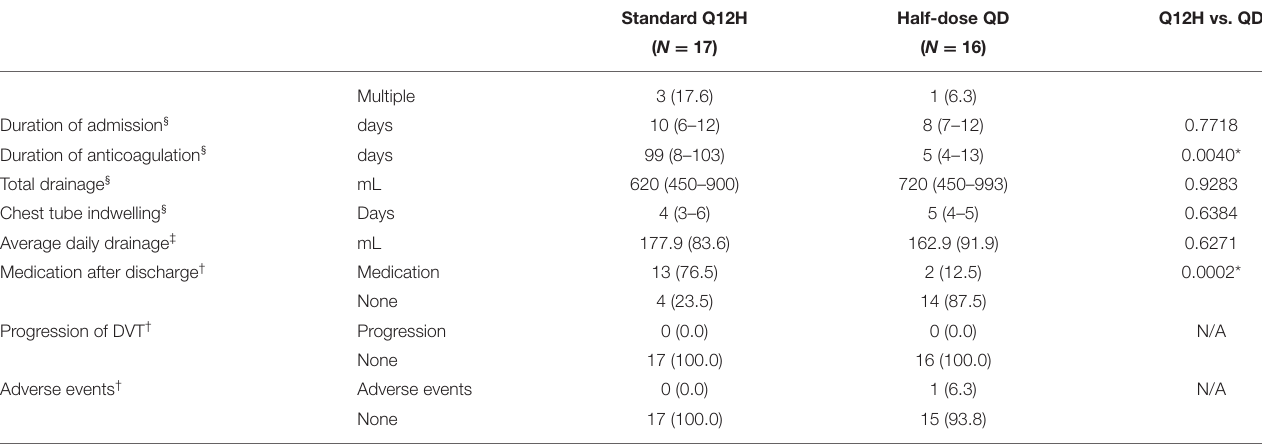
TABLE 6 | IDDVT statistics and anticoagulation therapy follow-up